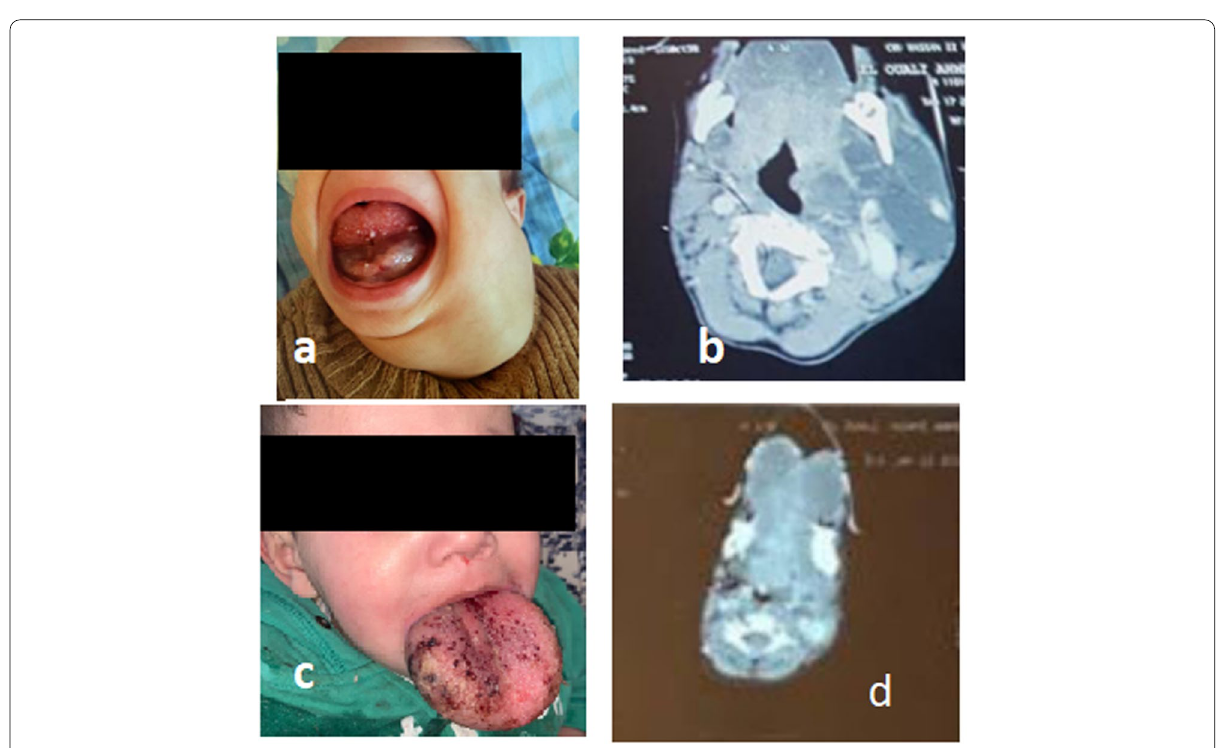
Fig. 3 Radiological findings in patient 3. a Preoperative clinical image showing showing cystic lesion in floor of mouth and adjacent cervical region. b Preoperative CT-scan section showing a cystic lesion in cervical region. c Post-operative clinical image showing macroglossia. d Post-operative CT-scan showing cystic aspect of the